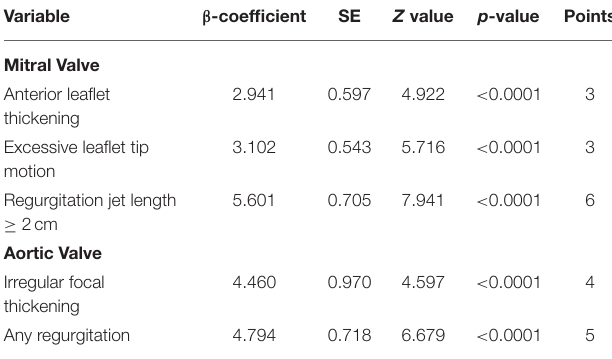
TABLE 1 | The World Heart Federation criteria for diagnosing RHD (14). Definite RHD (either A, B, C, or D) Definite RHD (either A, B, C, or D)